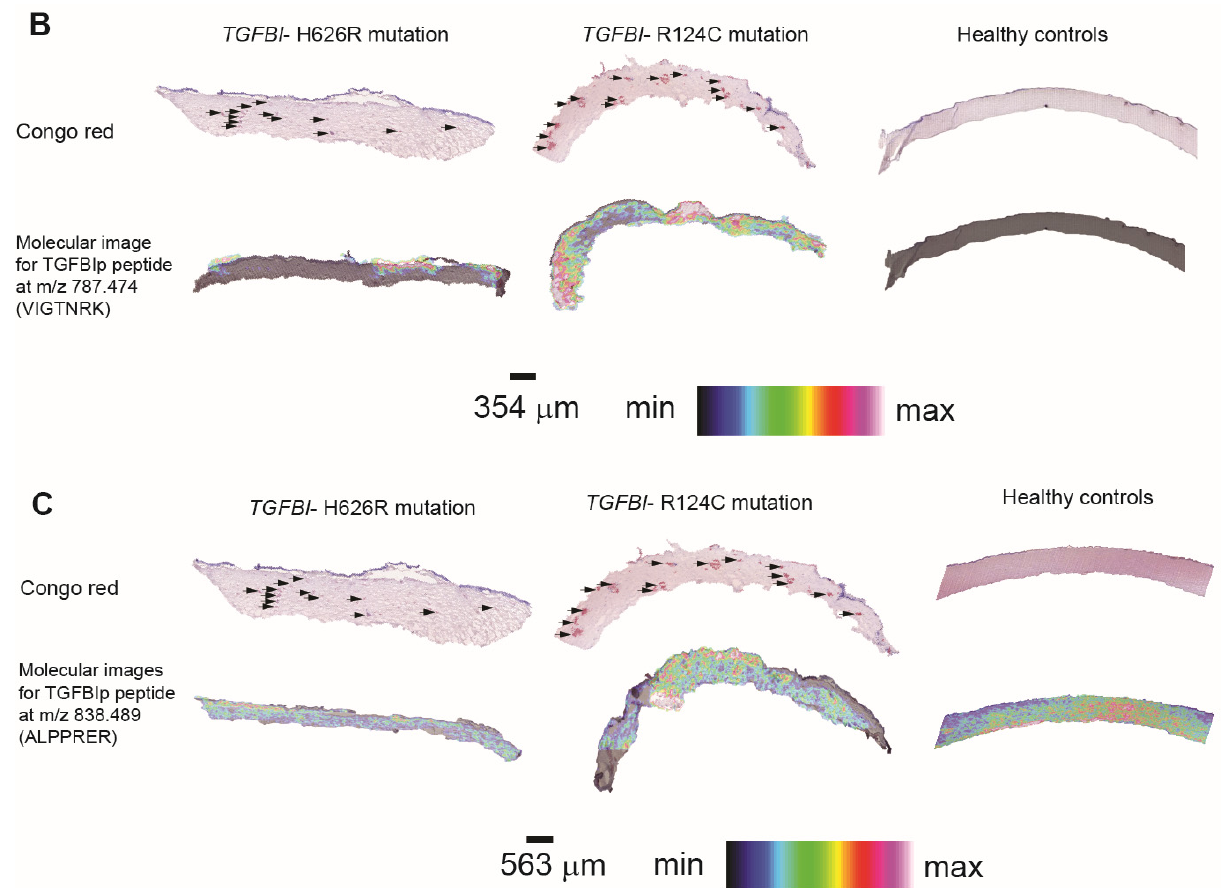
Figure 5. ( A – C ): MALDI-MSI Images showing the distribution of the five TGFBIp peptides in patient and donor control corneas. The congo red staining is also shown for the mutants and the control corneal tissue samples. The arrow marks in the congo red staining points the amyloid protein deposits in the patient. The patient with R124C mutation had more visible amyloid plaques than the patient with H626R mutation. The mass spectrometry imaging of most of the TGFBIp peptides colocalizes with the amyloid plaques in congo red staining indicating that mutant TGFBIp is the major component of the amyloid plaques. TGFBIp peptide is also found to be localized in other regions as TGFBIp is the second most abundant protein in the human cornea.